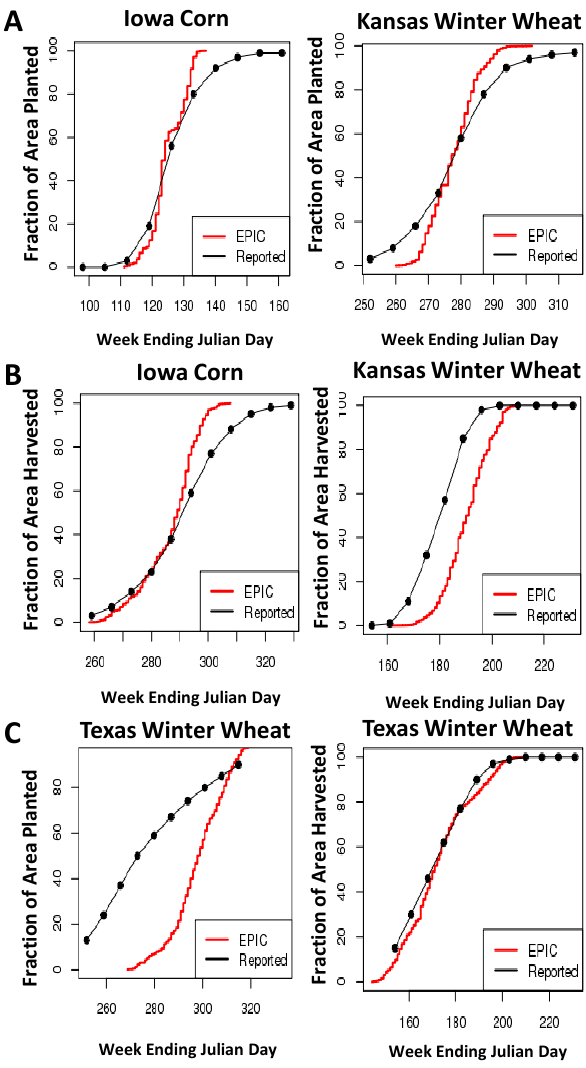
Fig. 4. Example comparison of USDA operation completion dates to EPIC heat-unit based estimates for rainfed (A) Iowa corn and Kansas winter wheat planting, (B) Iowa corn and Kansas winter wheat harvest and (C) Texas winter wheat plant and harvest